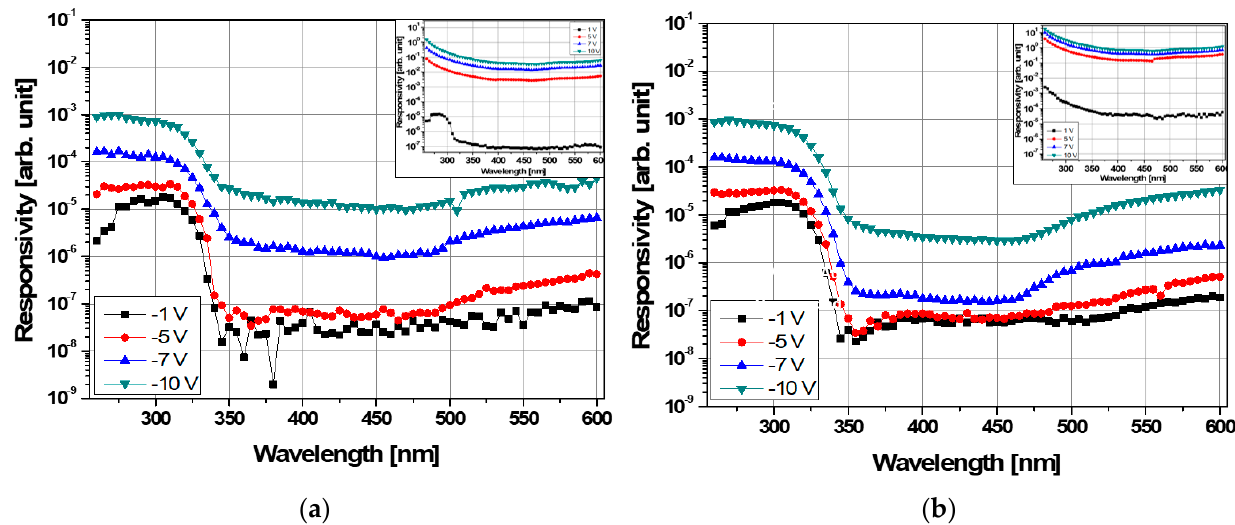
Figure 6. Spectral responsivity of the MSM AlGaN UV sensor ( a ) before and ( b ) after selective annealing under reverse bias. The insets show the spectral responsivity under forward bias.